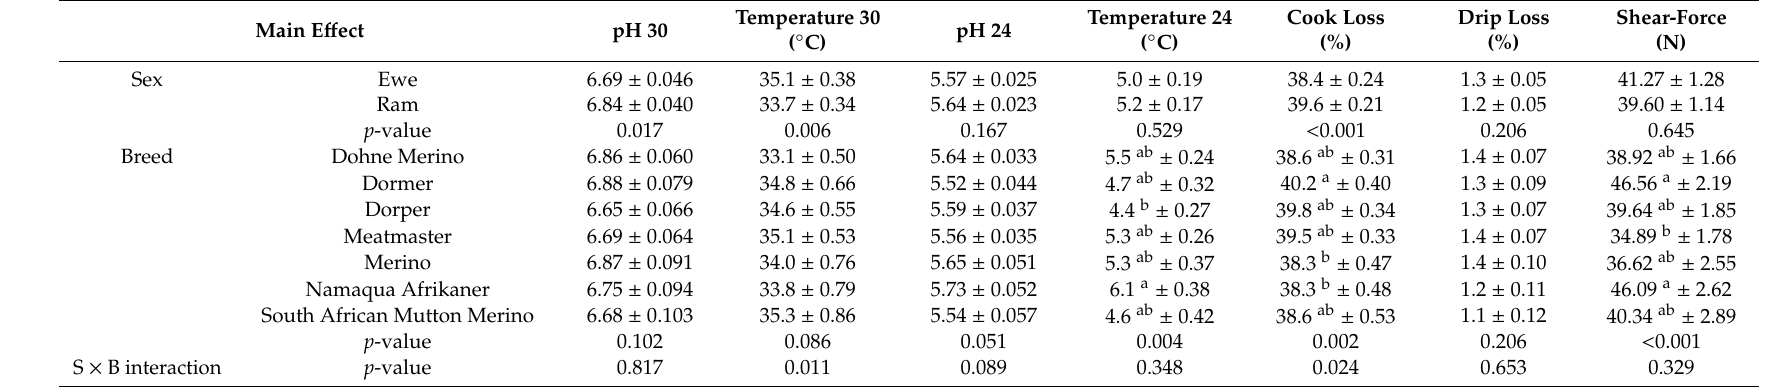
Table 6. Physical meat quality characteristics of the Longissimus lumborum muscles excised from A2 carcasses depending on the e ff ect of lamb sex and breed expressed as the least square means ± standard error.